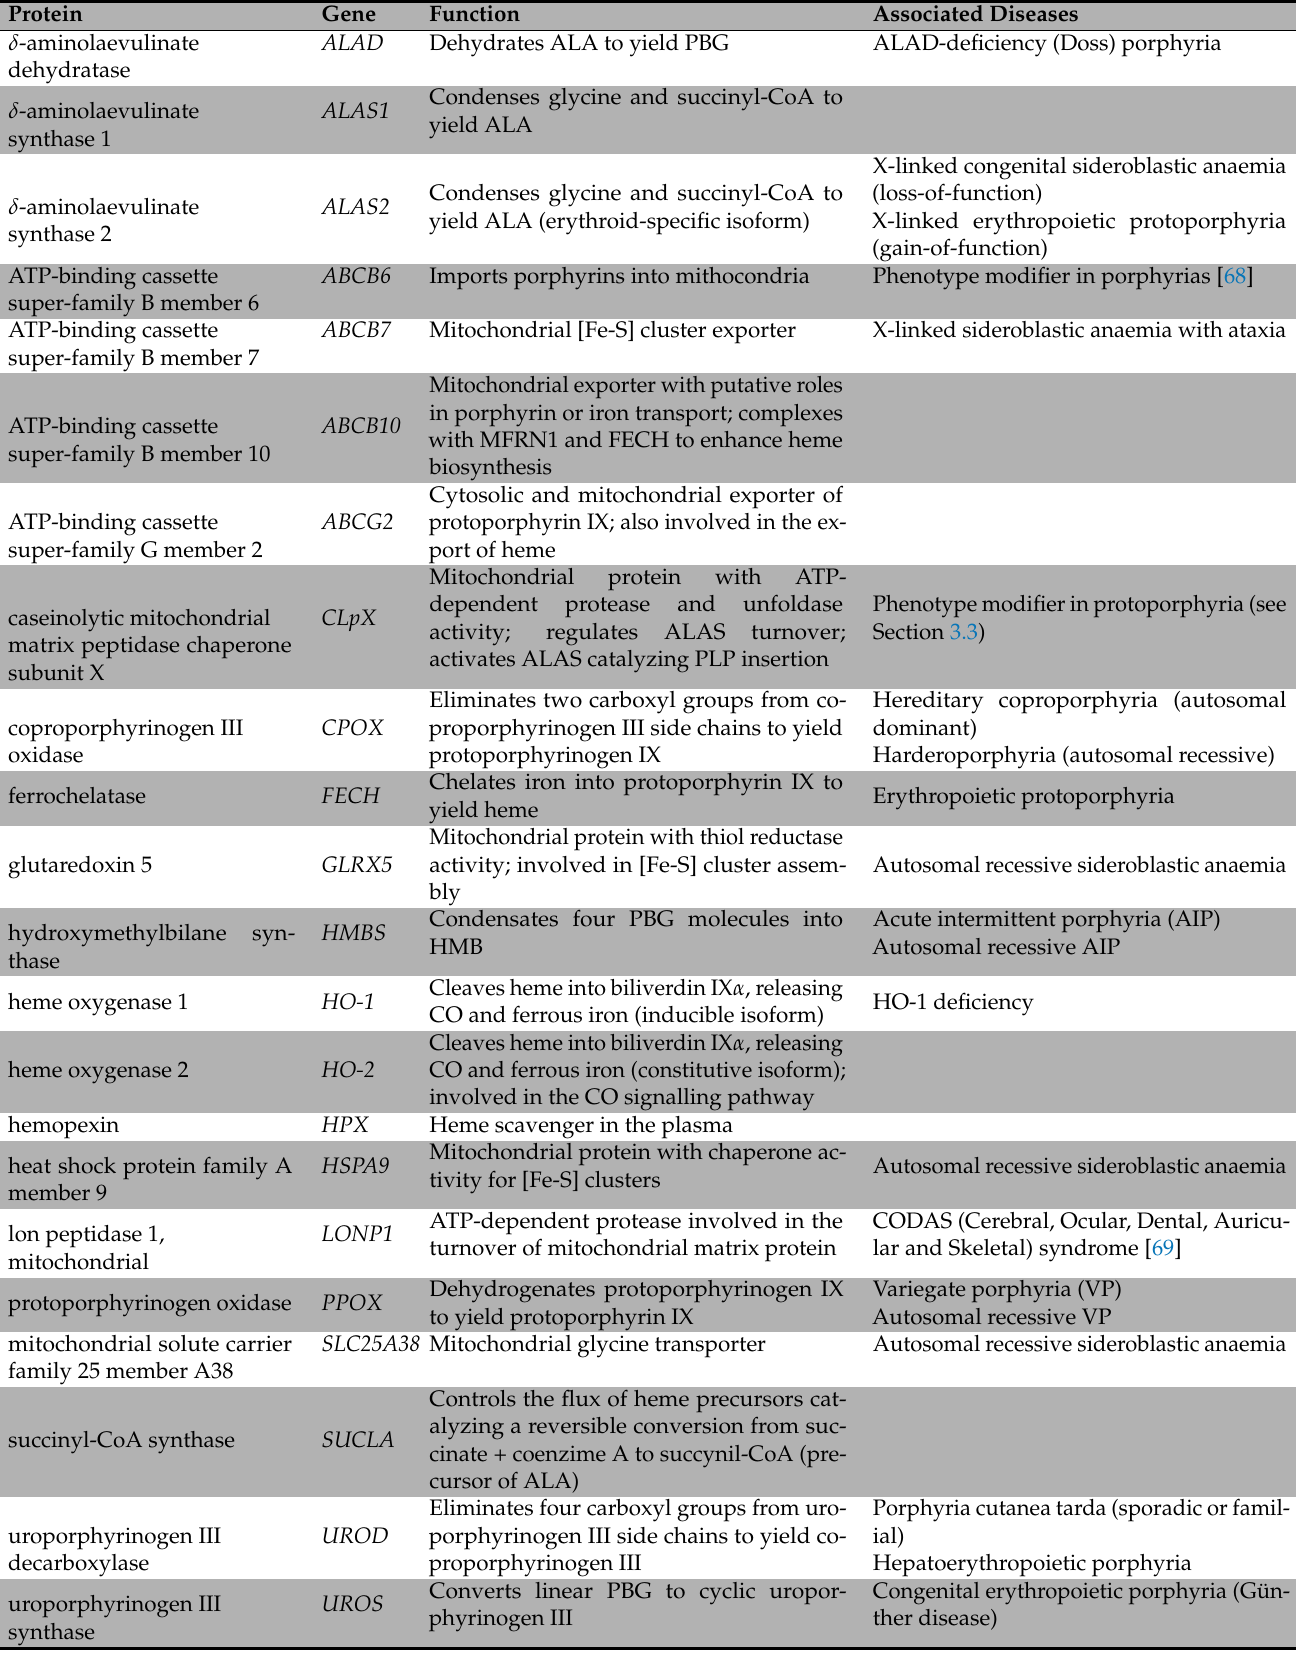
Table 2. Main actors of heme metabolism in